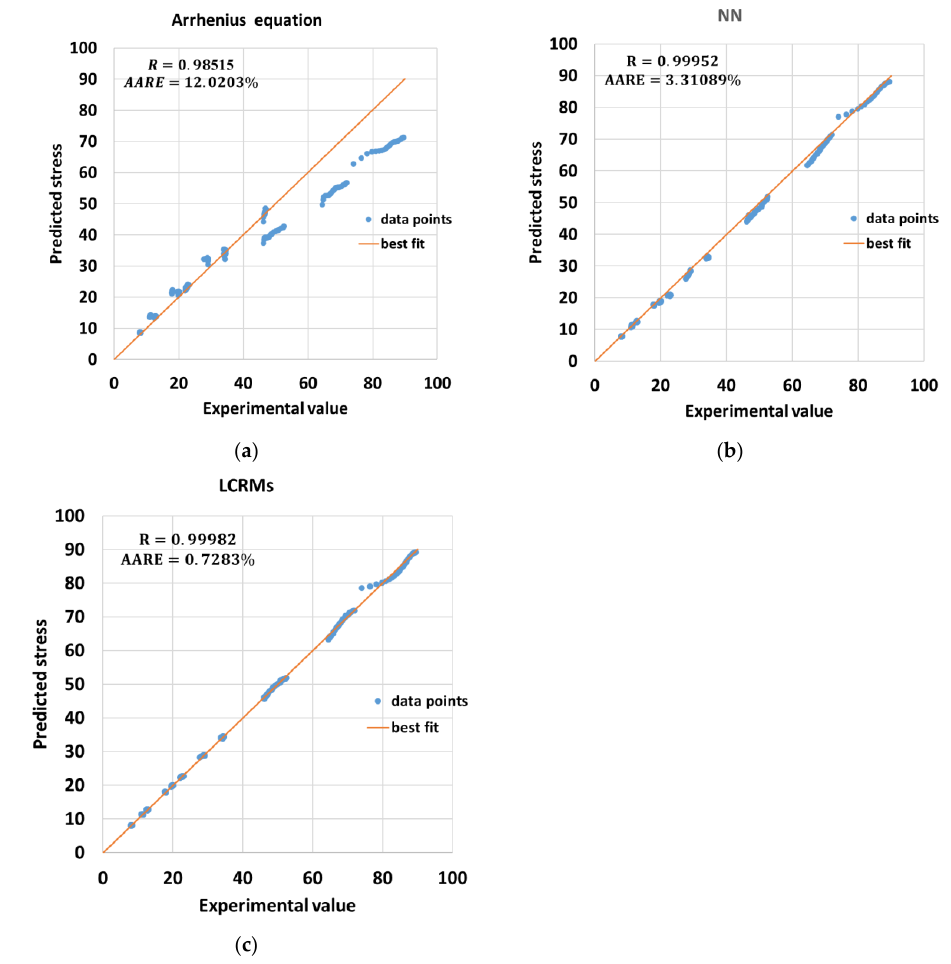
Figure 8. Correlation between experimental value and predicted value by ( a ) Arrhenius equation, ( b ) NN, and ( c ) LCRMs. Studies were performed to obtain the relative percentage errors of the three different models. Figure 9 shows the relationships between relative percentage error and relative frequency for the (a) Arrhenius equation, (b) NN, and (c) LCRMs. In each plot, the relative percentage errors were indicated by the mean error value μ and the standard deviation w. The absolute value of the mean of the relative percentage error by LCRMs was 0.029 while the absolute values of the mean obtained by the Arrhenius equation and NN were 2.381 and 3.165, respectively. The standard deviation of the relative percentage error ob- tained by the LCRMs was 0.998 while the standard deviations of the error derived by the Arrhenius equation and NN were 14.192 and 2.308, respectively. The results showed that the errors by the Arrhenius equation and NN were dispersed. The study of the relative percentage error indicates that the performances of the LCRMs were the most reliable compared to the Arrhenius equation and the NN. Meanwhile, it should be noted that the